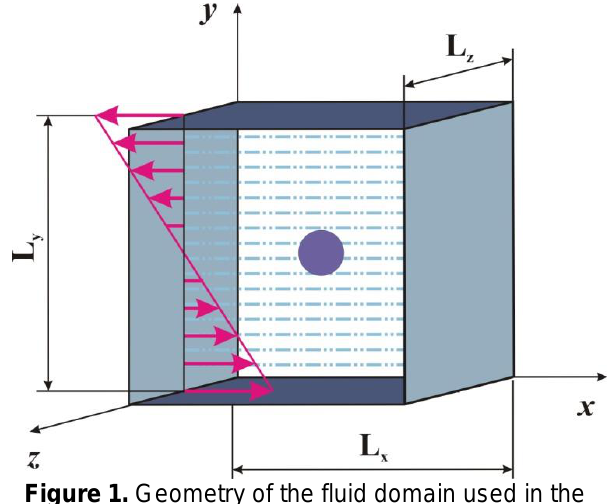
Figure 1. Geometry of the fluid domain used in the test